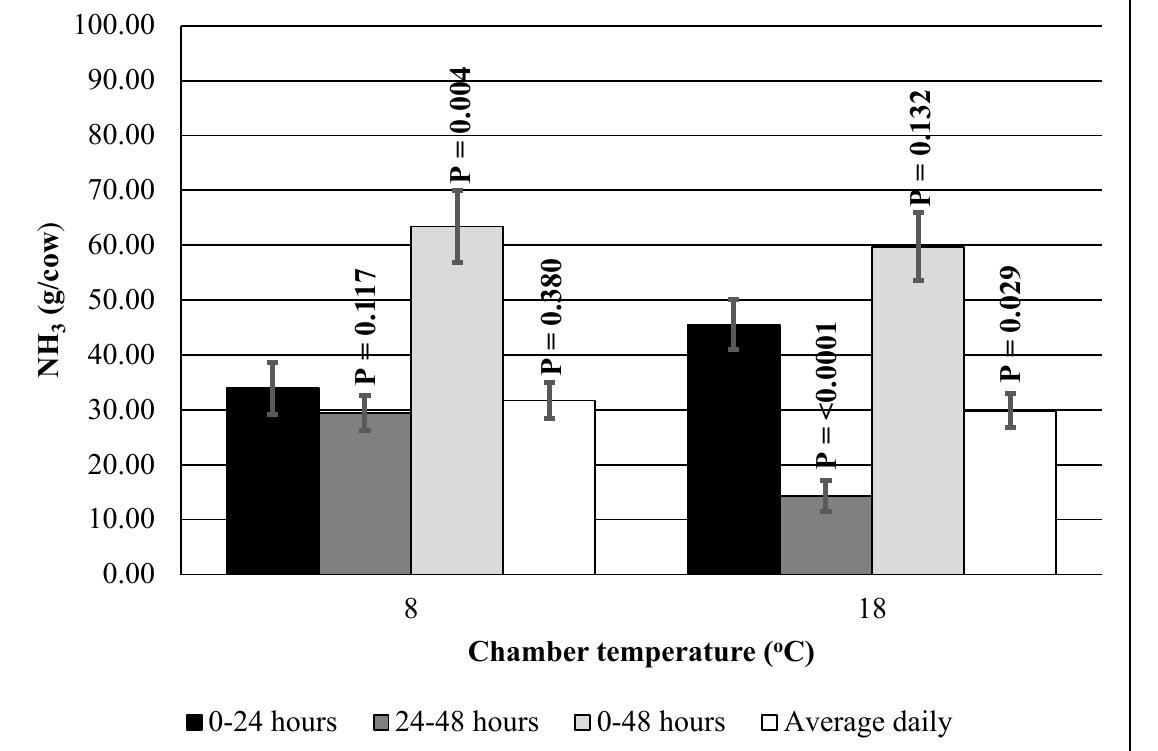
Figure 3. NH 3 emissions from slurry from lactating cows measured at 2 temperatures (8 and 18 °C) at different time intervals (0–24, 24–48, and 0–48 h) in open-circuit respiration chambers. The figure presents 24–48 and 0–48 h averages, as well as daily averages compared with the 0–24 h averages (within each chamber temperature) using the two-sample t -test. Vertical bars represent standard errors of the means.